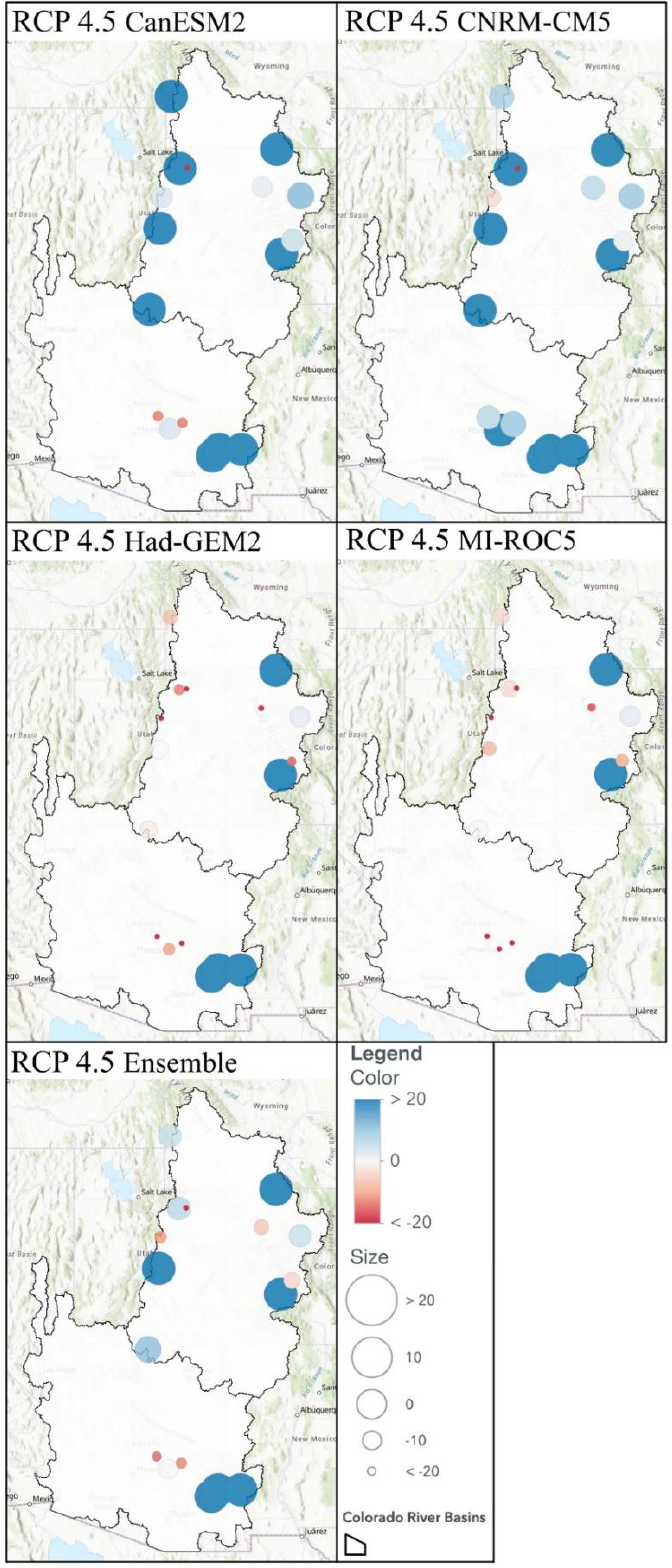
Figure 2. Spatial distribution of percentage change in mean projected water year streamflow for the period 2022 – 2099 for 4.5 RCP scenario, four models and ensemble.